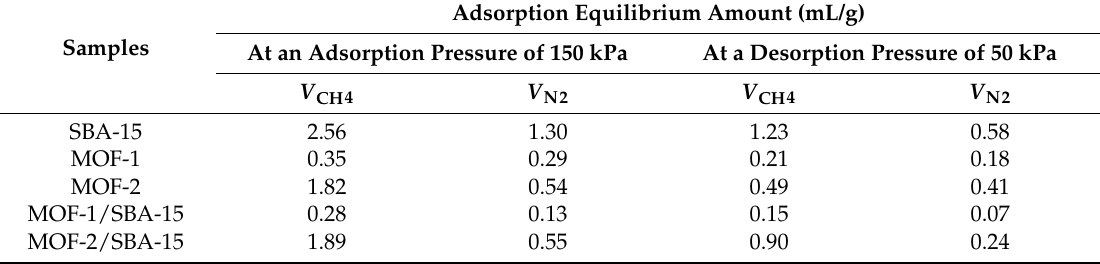
Table 4. Summary of the parameters related to the adsorption selectivity of the samples calculated from the pure gas adsorption